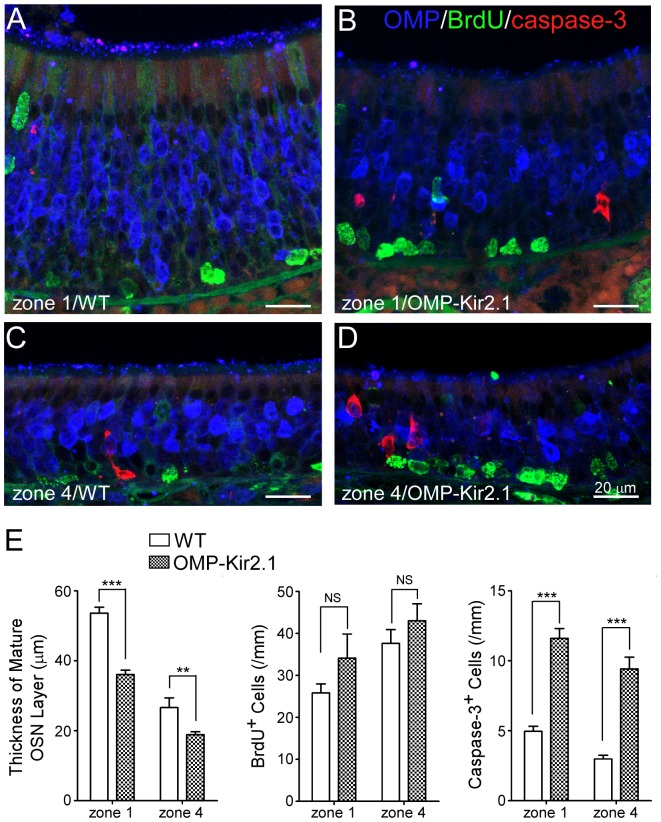
OMP-Kir2.1 mice have thinner olfactory epithelium with an increased density of apoptotic cells than wild-type controls.(A–D) Coronal sections from wild-type and OMP-Kir2.1 mice were stained with antibodies against OMP (blue), BrdU (green) and cleaved caspase-3 (red). Confocal images (projected from a stack of 5 images with z step = 3 µm) were taken from zone 1 and zone 4 in wild-type (A, C) and OMP-Kir2.1 (B, D) mice. (E) Summary of the thickness of mature OSN layer and the density of BrdU and caspase-3 positive cells in zone 1 and zone 4 from wild-type and OMP-Kir2.1 mice. Statistical significance was obtained by Bonferroni post-hoc tests: NS (not significant) indicates p>0.05, ** p<0.01, and *** p<0.001.